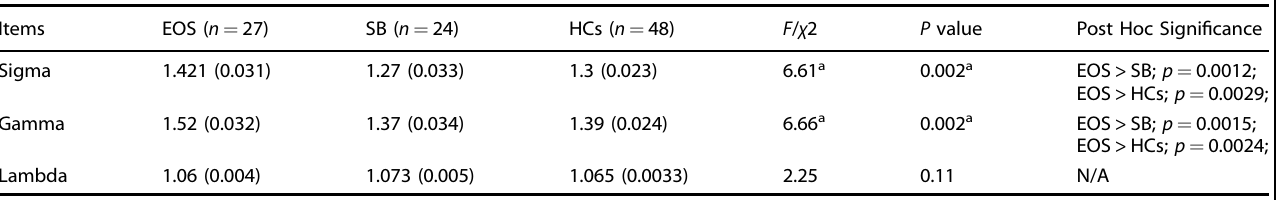
Table 2. Global network measures showing signi fi cant omnibus alteration.